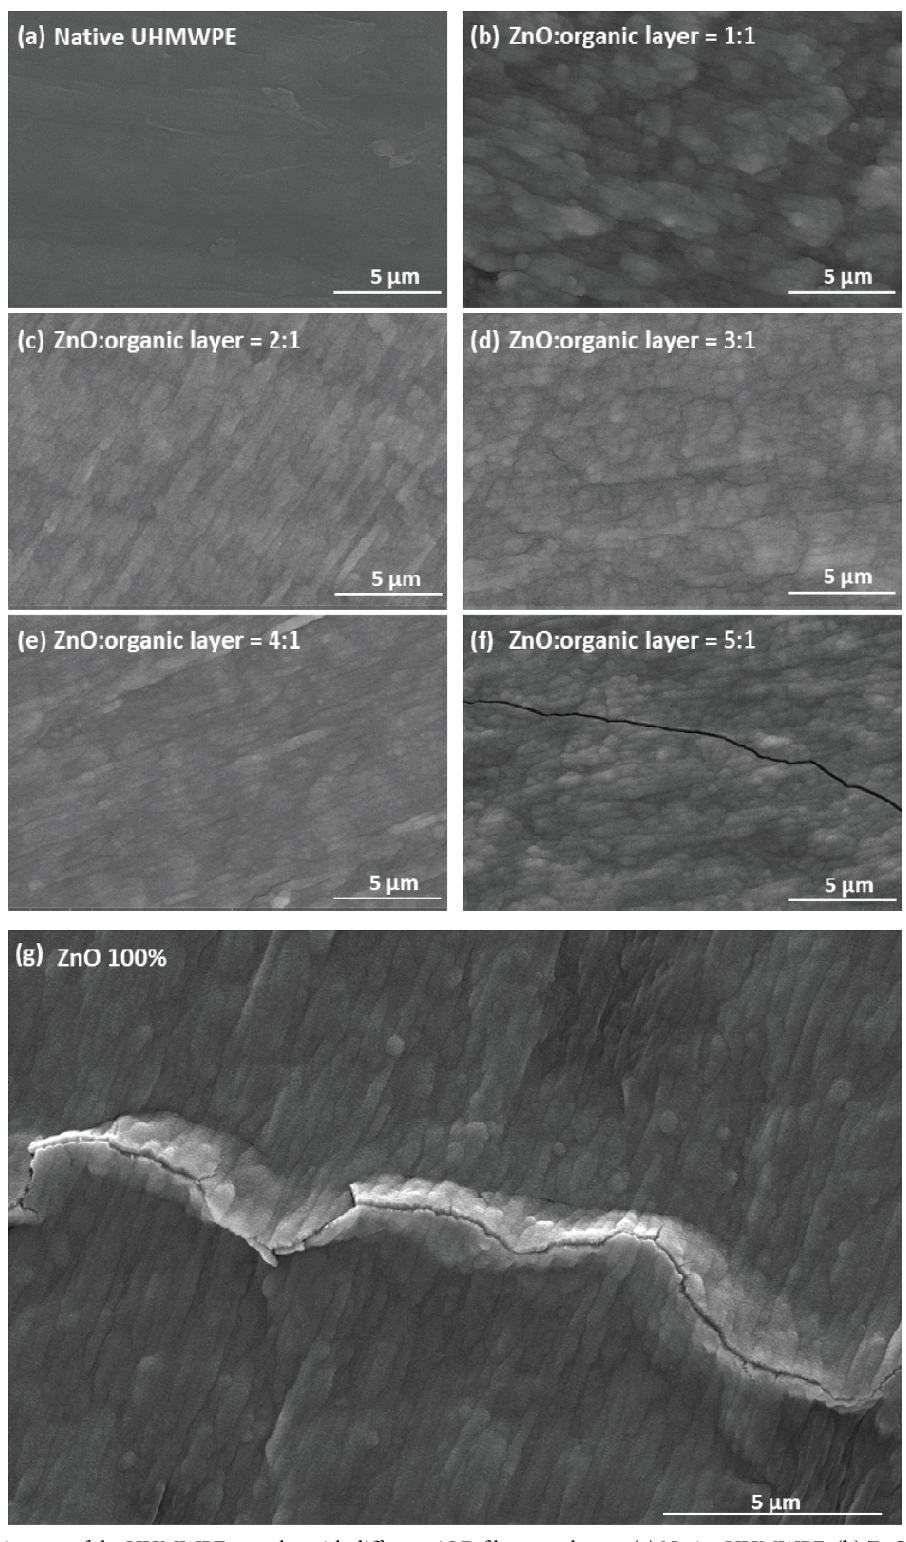
Figure 6: FE-SEM images of the UHMWPE samples with diferent ALD flms are shown. (a) Native UHMWPE. (b) ZnO :organic layer � 1: 1. (c) ZnO: organic layer � 2 :1. (d) ZnO :organic layer � 3:1. (e) ZnO: organic layer � 4:1. (f) ZnO: organic layer � 5 :1. (g) ZnO